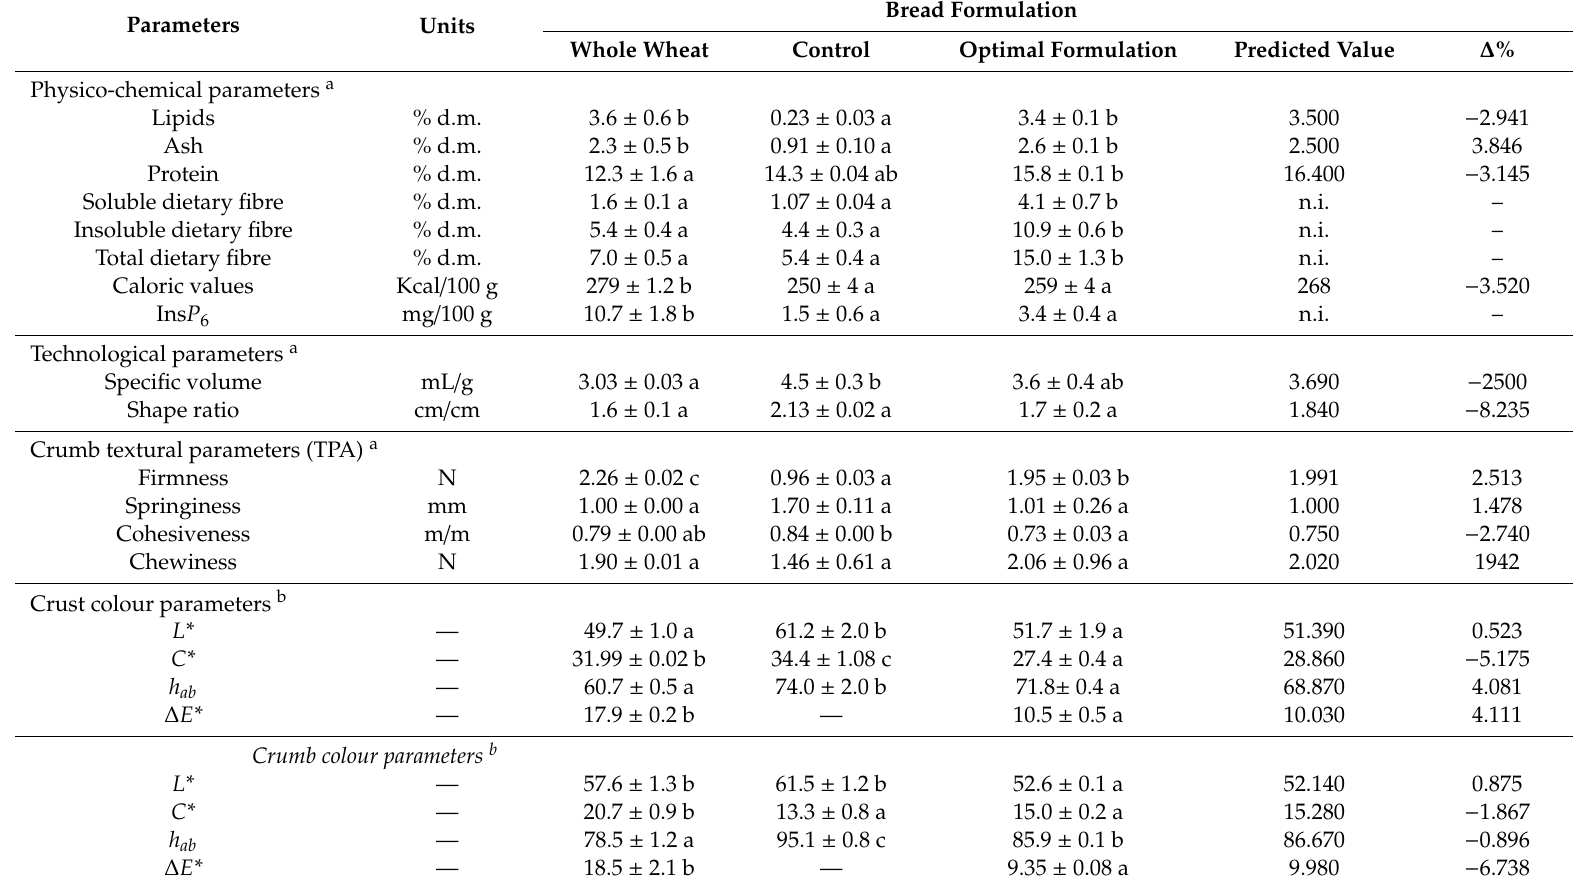
Table 4. Physico-chemical and sensory characteristics of bread